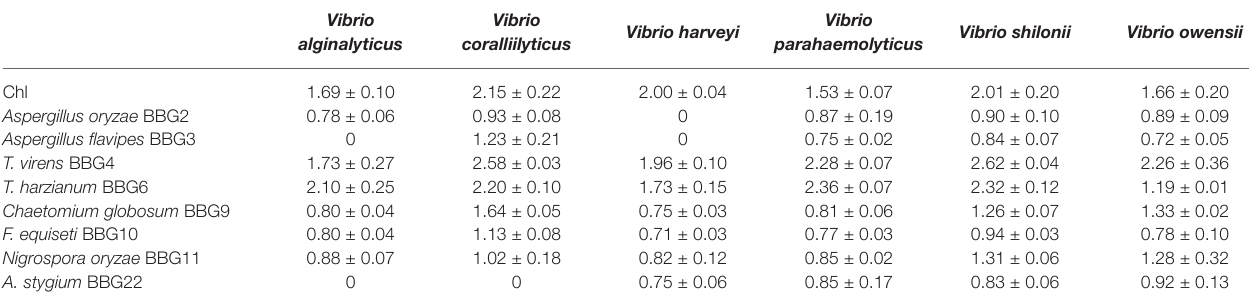
TABLE 1 | The anti- Vibrio activity of fungal extracts (diameter of inhibition zone,